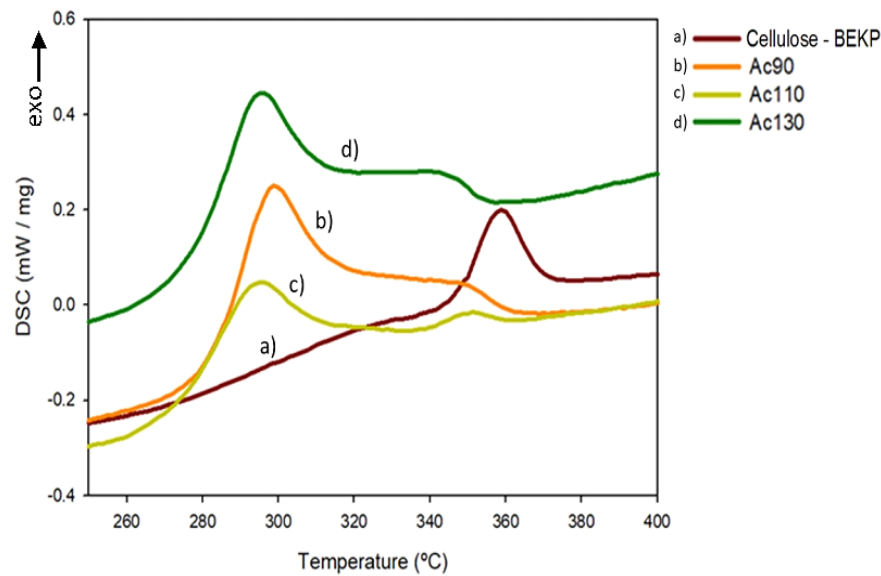
Figure 6. DSC thermograms of cellulose pulp and its films at the range of cellulose stability tem- perature of ( a ) cellulose—BEKP, ( b ) Ac90, ( c ) Ac110, ( d ) Ac130. ture of ( a ) cellulose—BEKP, ( b ) Ac90, ( c ) Ac110, ( d )